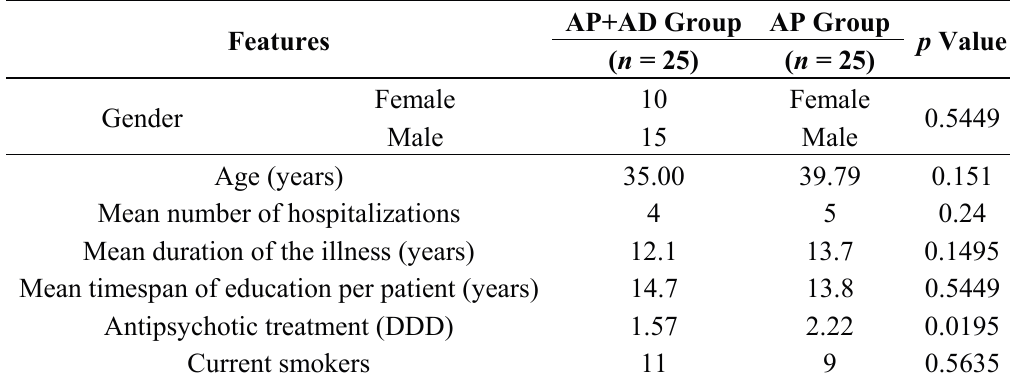
Table 1. Characteristics of groups.